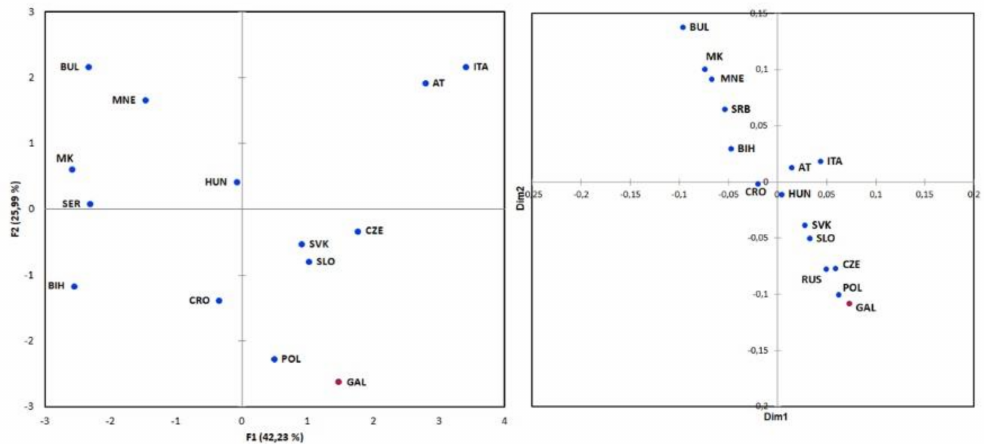
Figure 3. Population structure of the Galiˇcnik samples. Left: Principal component analysis (PCA) of the Galiˇcnik samples with 14 European populations based on raw haplogroups frequencies. Right: Multidimensional scaling (MDS) analysis of the Galiˇcnik samples with 15 European populations based on Rst distance matrix of YSTR haplotypes (AT-Austria, BIH-Bosnia and